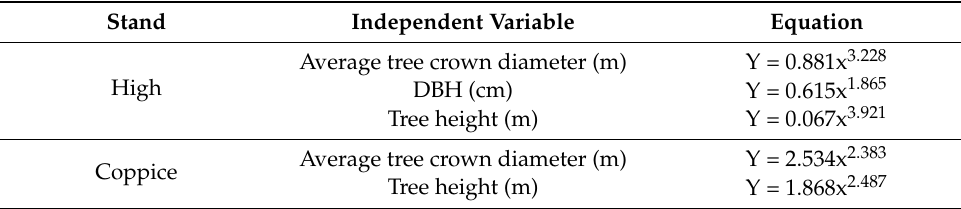
Table 1. Allometric equations for estimating biomass in Persian oak species.